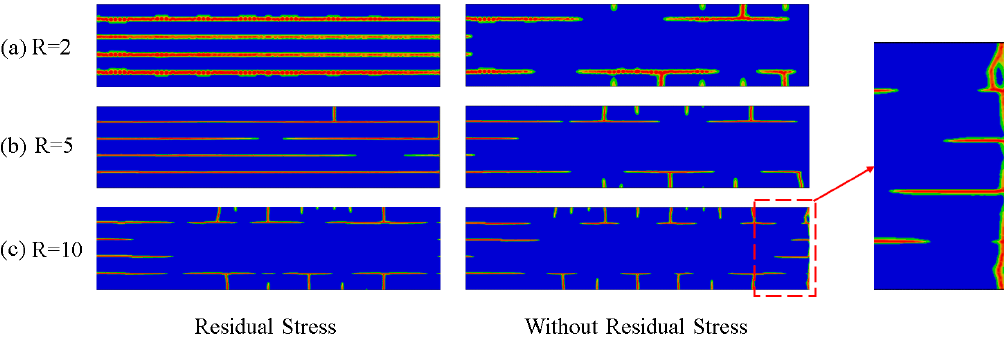
Figure 11. Numerical simulation results of thermal shock with different layer thickness ratios at an initial temperature of 300 °C.